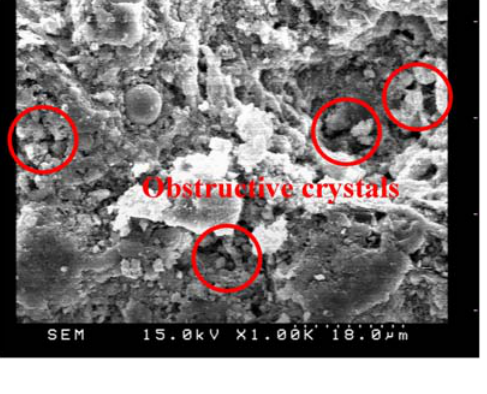
Figure 19. SEM micrograph of the cement-based material with fly ash admixture after leaching (×1